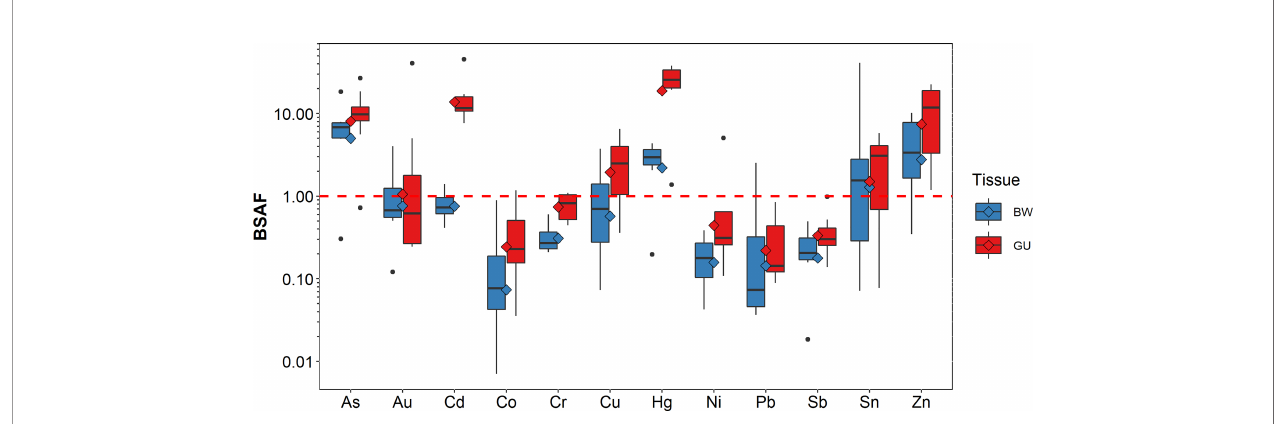
FIGURE 7 | Boxplots (median, interquartile, 1.5 interquartile and outliers) of the biota-sediment accumulation factors (BSAFs) for each element in body wall (BW, in blue) and guts (GU, in red) among sites. Mean values are also shown (diamond